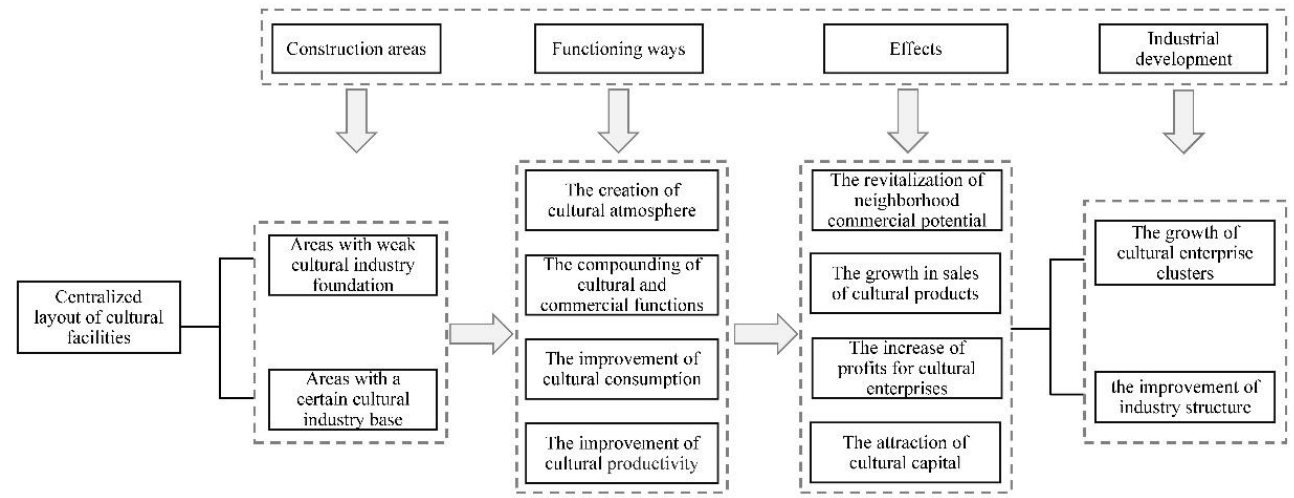
Figure 9. The promotion mechanism of cultural facilities for the development of cultural industry in the central district of Ningbo.